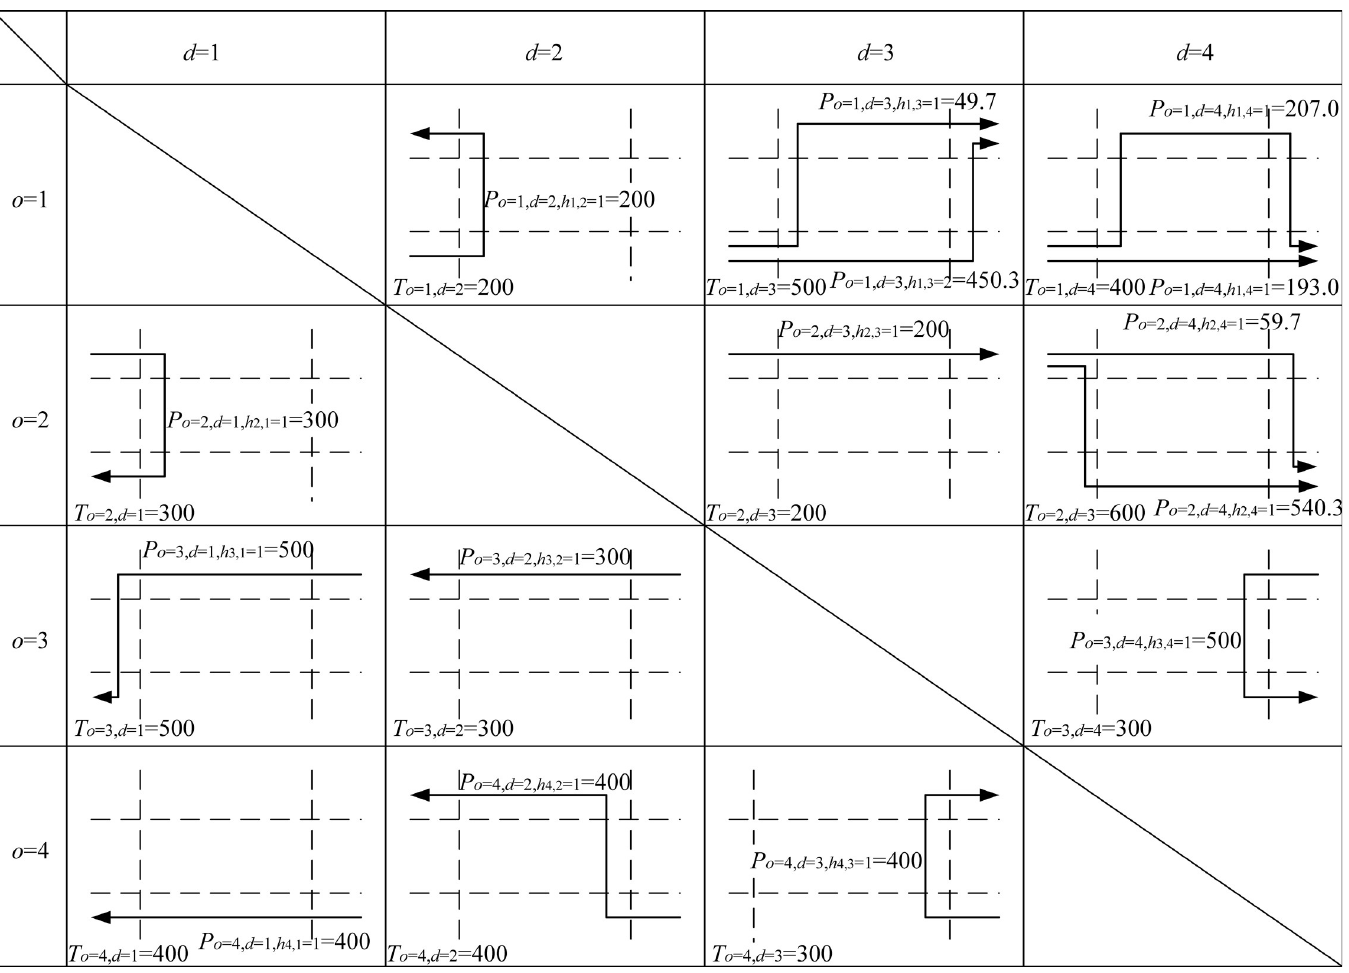
Fig 14. Path flow patterns by maximizing the common flow multiplier m (= 1.075) with cycle length z ¼ 1 = 120 : 0 s.